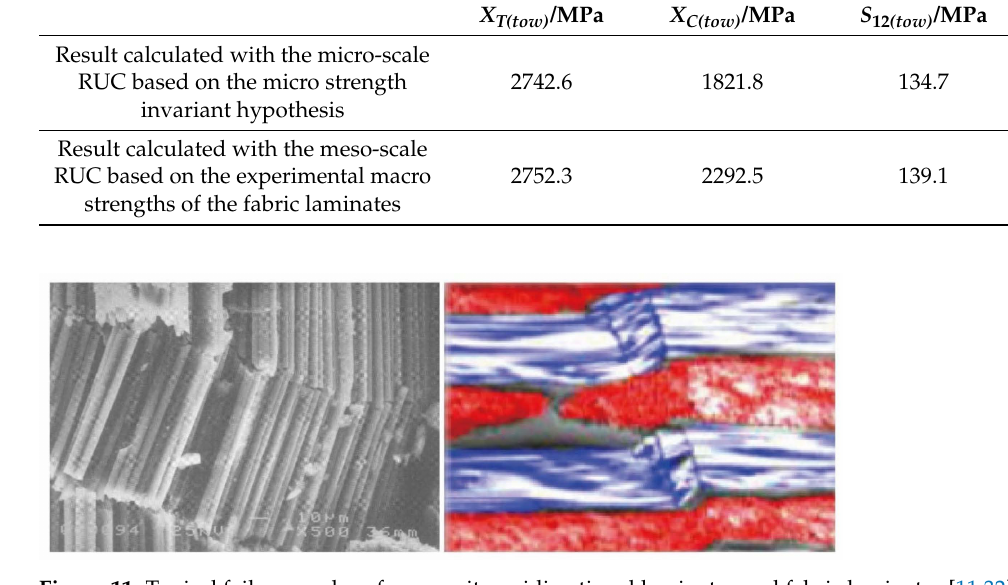
Figure 11. Typical failure modes of composite unidirectional laminates and fabric laminates [11,32]. The corrected meso-scale strengths of the fiber tows in the studied T300/Cycom970 fabrics are listed in Table 10, along with the corresponding micro-scale strengths of the constituents suitable for the T300/Cycom970. Table 10. The meso-scale strengths of the fiber tows and the micro-scale strengths of the constituents suitable for the T300/Cycom970 plain-woven